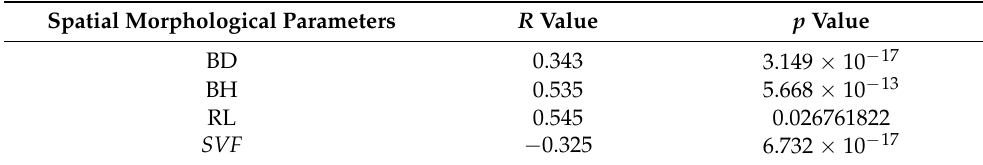
Figure 15. Spatial distribution of the ventilation potential coefficient in Shenzhen. Table 6. Pearson correlation between VPC and spatial morphological parameters.